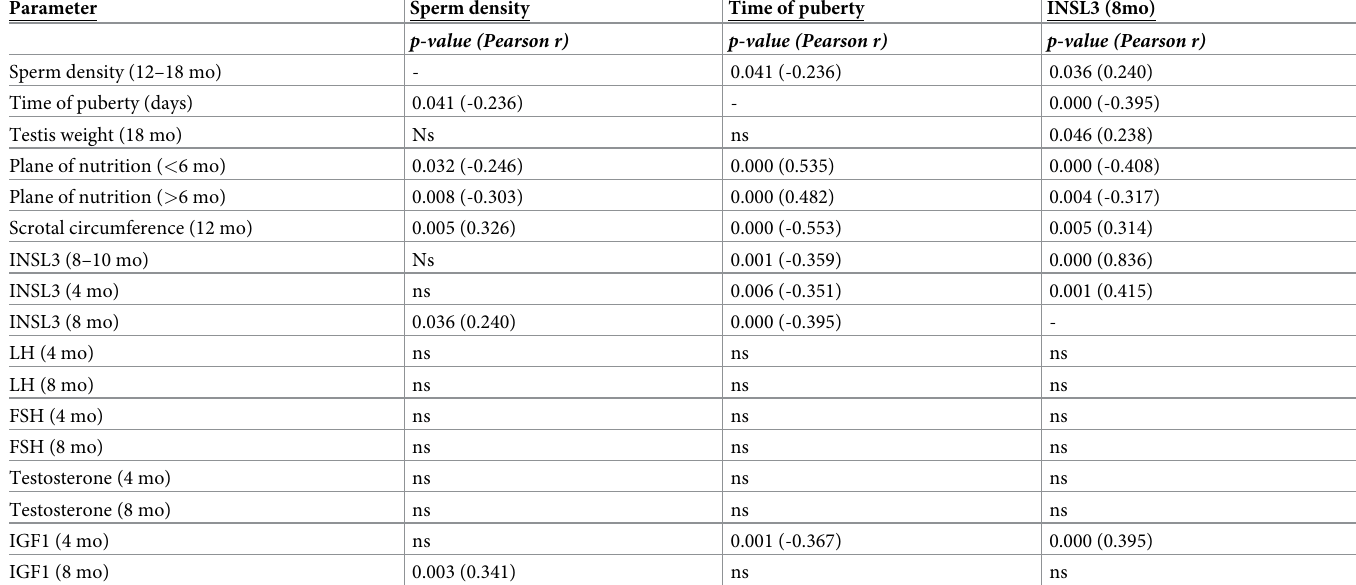
Table 1. Multiple correlation analysis.